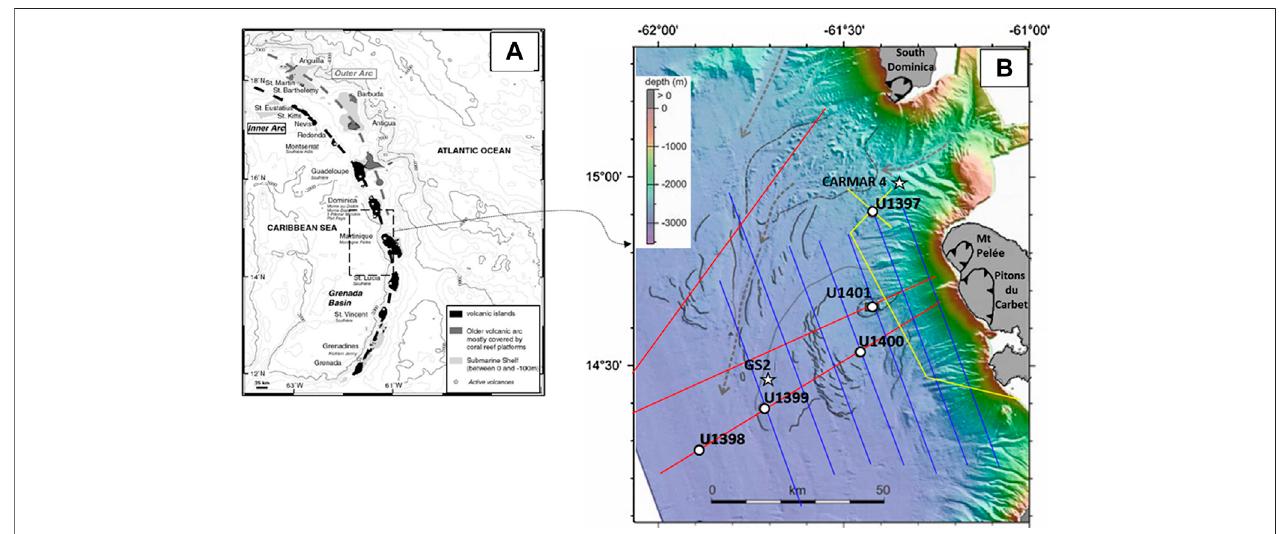
FIGURE 1 | Lesser Antilles Arc, landslide deposits, and IODP 340 coring sites offshore Martinique. (A) Two island arcs. The inner arc is the active volcanic arc (modi fi ed from Boudon et al. (2007)). (B) IODP 340 drilling sites and extent of chaotic units. Submarine topography: swath bathymetry illuminated from the North; gray lines:topographicscarps(DAD3istheblockyunitabovewhichislocatedtheU1401site;otherscarpscorrespondtoSLDslimits);grayarrows:maindeepseachannels. Colored lines are seismic re fl ection lines used to locate the coring sites (blue: AGUADOMAR cruise, 1999, Red: CARAVAL cruise, 2002, Yellow: GWADASEIS cruise,2009,Deplusetal.,2001;LeFriantetal.,2003).Drillingsites:opencircles:IODP340cores;stars:CARMAR-4(CARAVALcruise)andGS-2(Gs7605cruise;Reid et al., 1996). On-land black scars: fl ank collapse structures of Martinique (Mt Pelée and Pitons du Carbet) and South Dominica (modi fi ed from Boudon et al. (2013)).